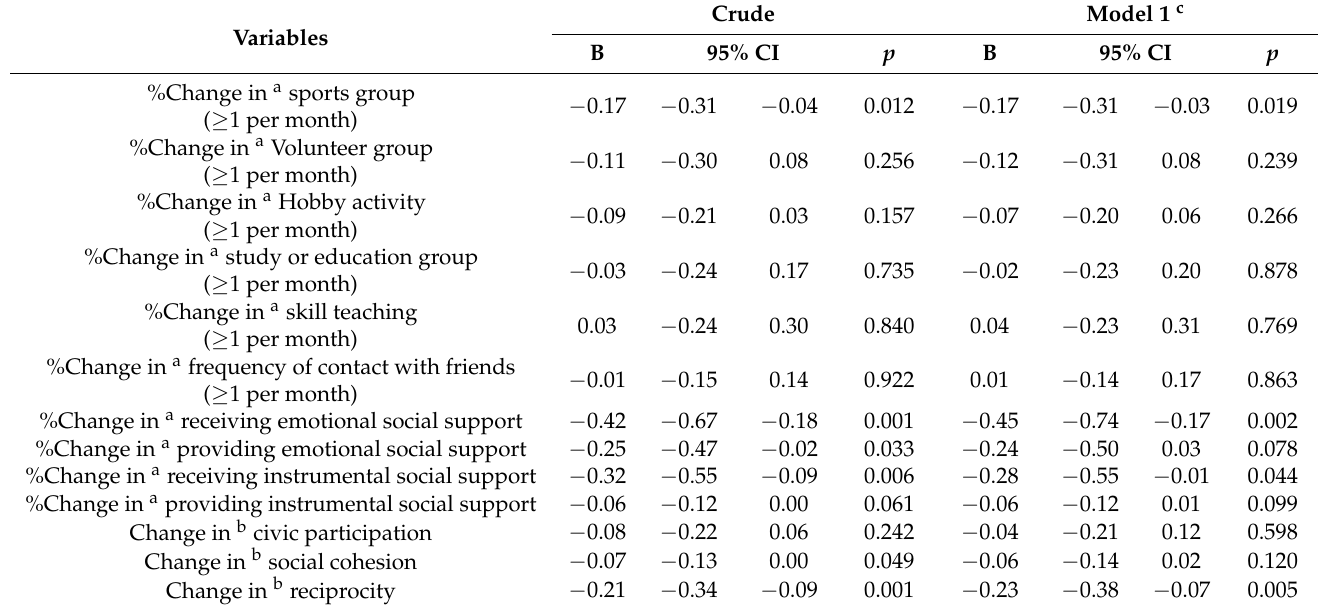
Table 2. Multiple linear regression of changes in health-related social capital indicators with changes in smoking ( n = 69 municipal